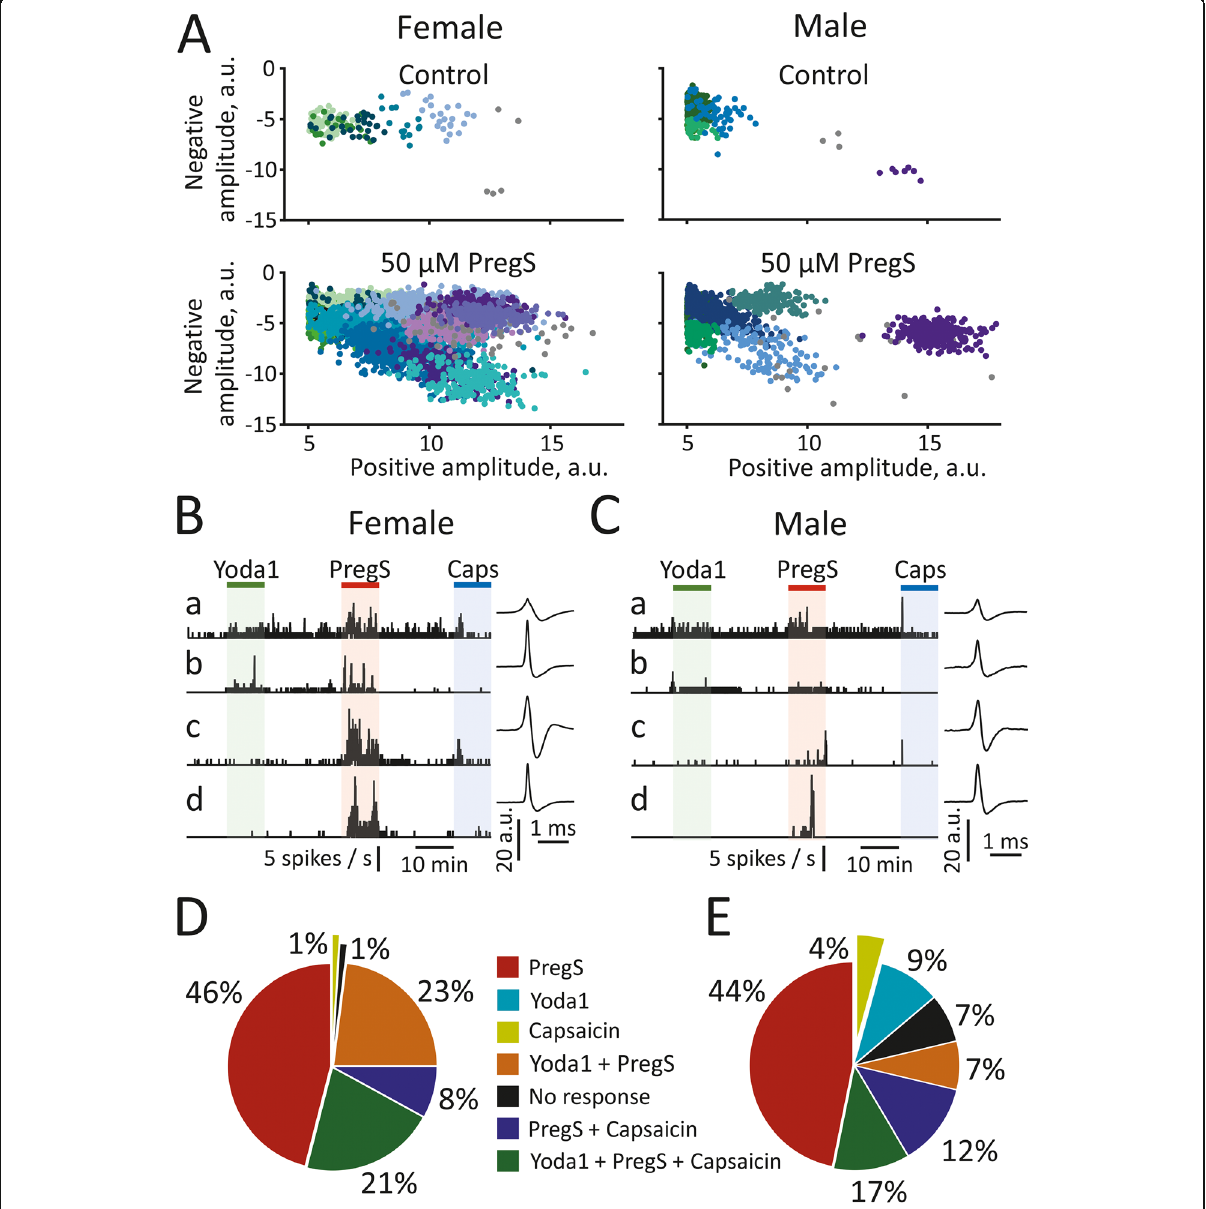
Fig. 5 Co-activation of TRPM3 mechanosensitive receptors, Piezo1 mechanosensitive receptors, and TRPV1 channels. ( A ) Presentation of spike clusters within one experiment. Spikes are plotted by separating negative vs. positive amplitude in the control condition (top panels) and after 50 μ M PregS application (bottom panels) in females (left) and males (right). Each individual dot indicates a single spike. Dots with similar colours represent one cluster (i.e. representing one fibre or one group of spikes, as separated by the KlustaKwik method. (B, C) Examples of clusters within one nerve of female ( B ) and male ( C ) meninges that were sequentially activated by all three agonists ( Ba, Ca ), both 5 μ M Yoda1 and 50 μ M PregS ( Bb, Cb ) or both 50 μ M PregS and 1 μ M capsaicin ( Bc, Cc ), or only 50 μ M PregS ( Bd, Cd ). Spike shapes are depicted for each cluster. (D, E) Pie diagrams demonstrate the averaged percentage of clusters with various neurochemical profiles in females ( D ) and males ( E ) . Data are presented from 7 and 5 experiments in females and males, respectively. Notice, the difference in co-appearance of responses to 5 μ M Yoda1 and 50 μ M PregS in females and males. In females, up to 44% clusters were activated by PregS and Yoda1 (23%) or by PregS, Yoda1 and capsaicin (21%), whereas in males, the number of such ‘ supermechanosensitive ’ fibres was only 24% (PregS and Yoda1 (7%); PregS, Yoda1 and capsaicin (17%)). In males, 7% of clusters showed no response to any agonist, whereas this was the case for only 1% of clusters in females where, in addition, no fibres responded only to 5 μ M